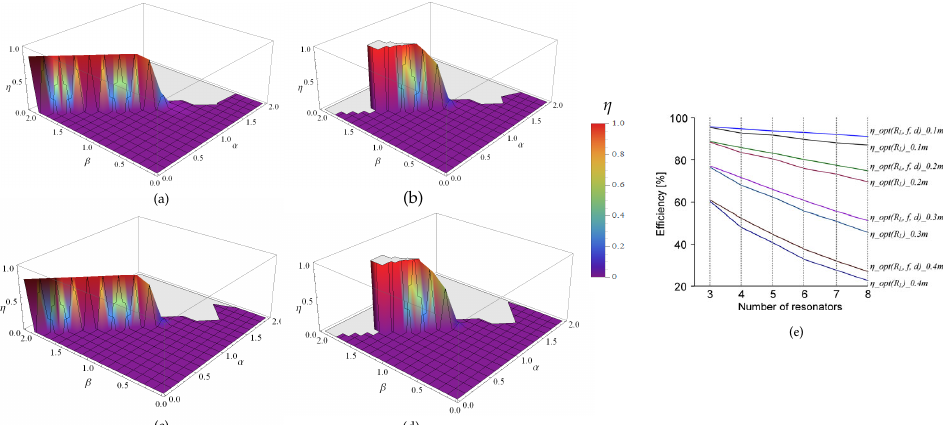
Figure 8. Relationship curves among α , β , and P o : Variations of 0 < α < 2 and 0 < β < 2. In detail, Figure 8. 3D plot of relationships among α , β , and P o : Variations of 0 < α < 2 and 0 < β < 2. In detail, sub-figures demonstrate the details of 3D plots of (a) FO-WPDRS with 3 resonators, (b) FO-WPDRS sub-figures demonstrate the details of 3D plots of ( a ) FO-WPDRS with 3 resonators, ( b ) FO-WPDRS with 4 resonators, (c) FO-WPDRS with 5 resonators, and (d) FO-WPDRS with 6 resonators. with 4 resonators, ( c ) FO-WPDRS with 5 resonators, and ( d ) FO-WPDRS with 6 resonators. VersionAugust26,2018submittedto Energies